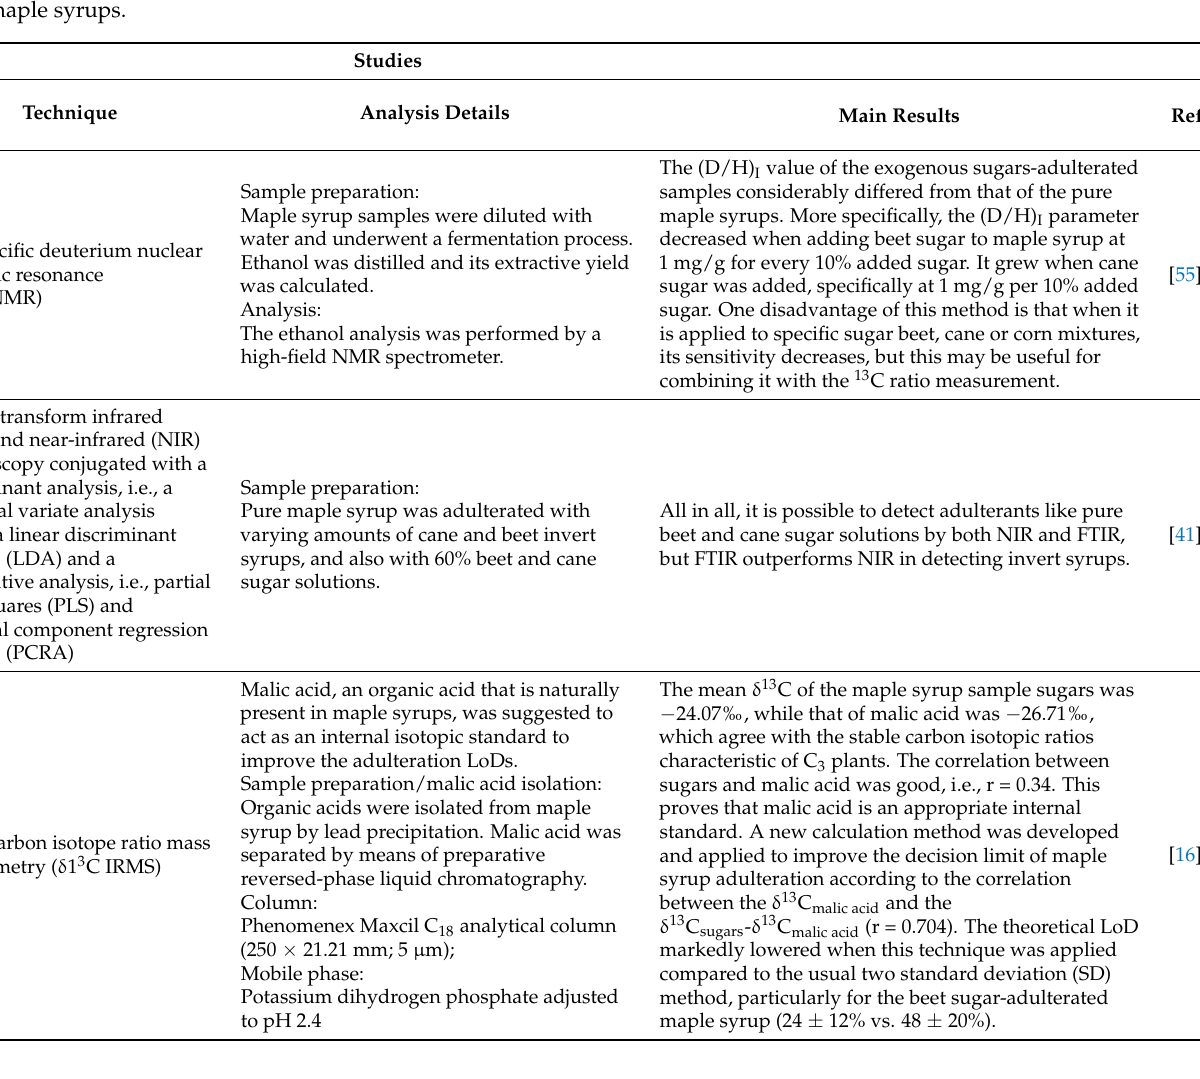
Table 3. Detection of adulterants in maple